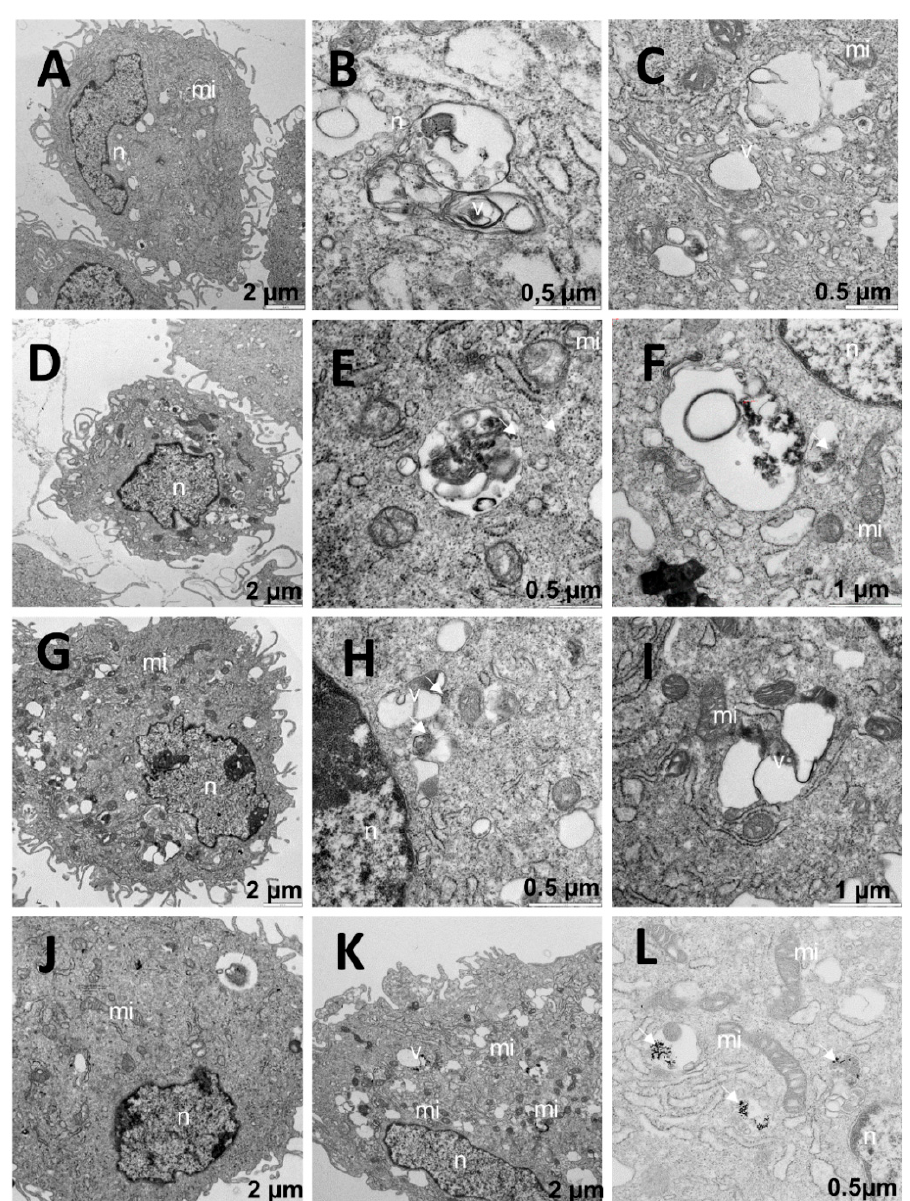
Figure 9. TEM images of BJ-hTERT cells and control cells ( A – C ); TEM images of cells treated with Au@16-pH-16, N 1 ( D – F ), N 2 ( G – I ), and N 3 ( J – L ). Dense bodies compatible with gold cores of nanoparticles are indicated by arrows. Abbreviations: mi: mitochondria; n: nucleus; v: vesicle.